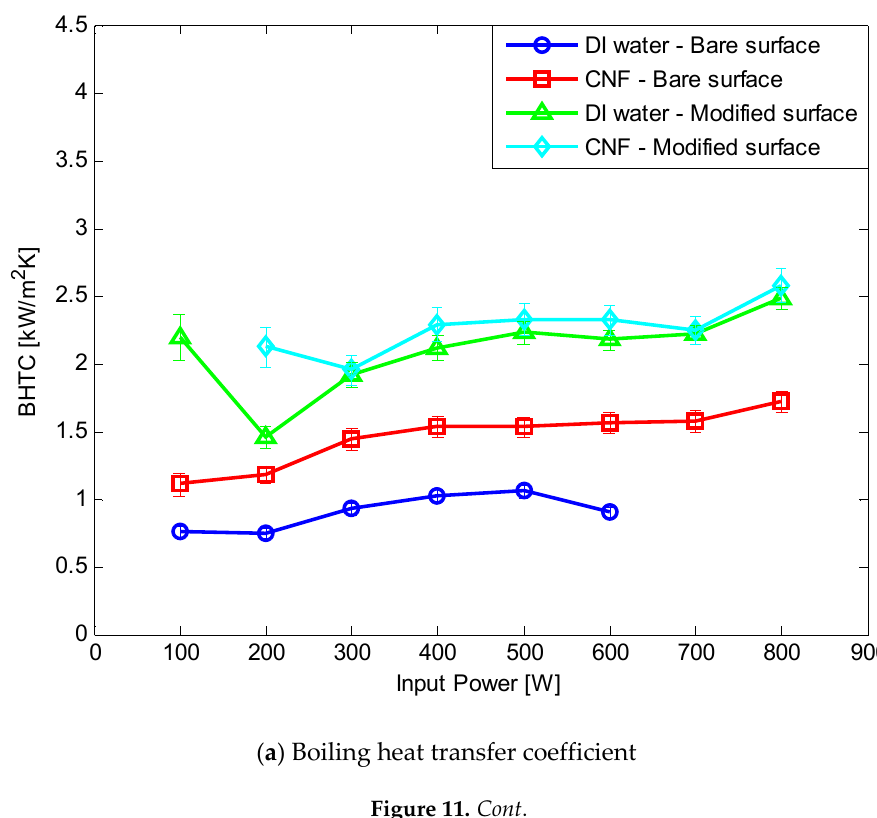
Figure 10. Comparison of experiment result at FR 0.25.